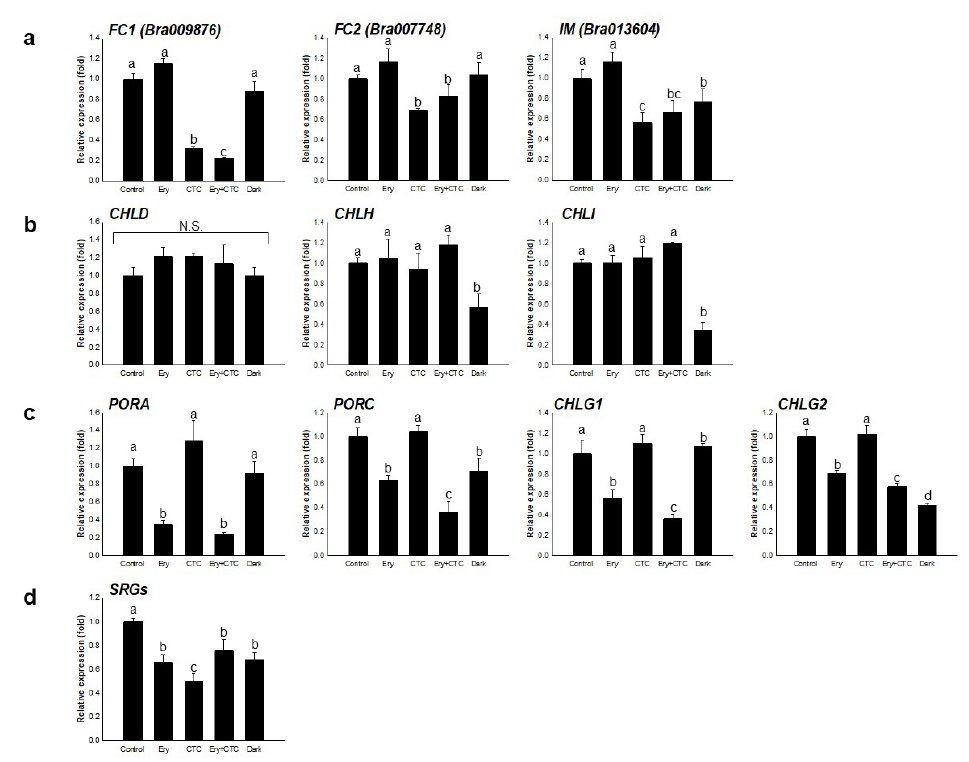
Figure 3. Effect of veterinary antibiotics on expression of genes involved in the regulation of chlorophyll content. Expression levels of the genes marked in bold in Figure S3 were determined by qRT-PCR analysis of total RNA extracted from B. campestris seedlings grown in the light for 5 days under the following conditions: control, no antibiotics; Ery, 5 mg/L erythromycin; CTC, 5 mg/L chlortetracycline; Ery + CTC, 5 mg/L erythromycin and 5 mg/L chlortetracycline; dark, no antibiotics and complete darkness for 5 days. ( a ) Expression of FC1 ( Bra009876 ), FC2 ( Bra007748 ), and IMMUTANS ( IM ; Bra013604 ). ( b ) Expression of CHLH ( Bra006208 ), CHLD ( Bra018619 ), and CHLI ( Bra012595 and Bra013314 ). ( c ) Expression of PORA ( Bra003004 ), PORC ( Bra033415 and Bra030540 ), CHLG1 ( Bra040893 ), and CHLG2 ( Bra028411 ). ( d ) Expression of SGRs ( Bra019346 and Bra000755 ). Expression of each gene was normalized against expression of the reference gene EF1 α . Bars represent means ± SD ( n = 20); the experiments were replicated three times with similar results. Different letters above bars indicate a statistically significant difference within each treatment as determined by one-way analysis of variance (ANOVA) and Tukey’s honestly significant difference (HSD) test, p < 0.05. N.S. = no significant differences among